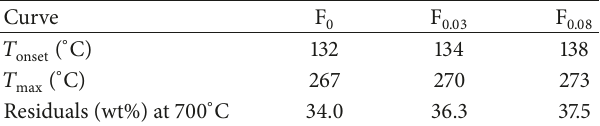
highly aligned structure, and all present the smooth surface. Table 2: Thermal property of TGA curves of composite films (F 0 , F 0.03 , and F 0.08